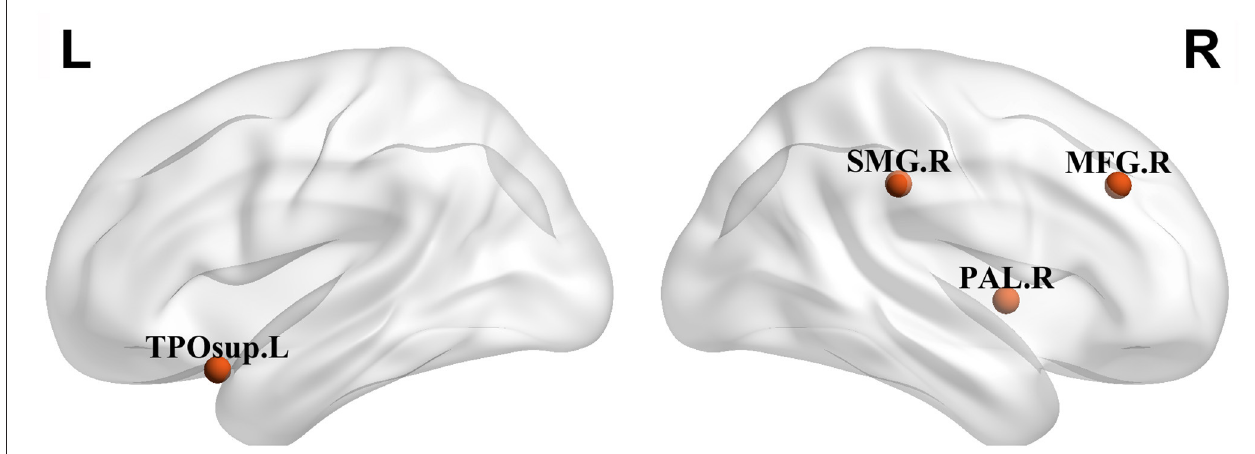
FIGURE 1 | Regions with significant alterations both in nodal degree and nodal efficiency in patients with craniocervical dystonia (CCD) in comparison with healthy controls. TPOsup., temporal pole, superior temporal gyrus; MFG, middle frontal gyrus; Pall., pallidus globus; and SMG, superior marginal gyrus.